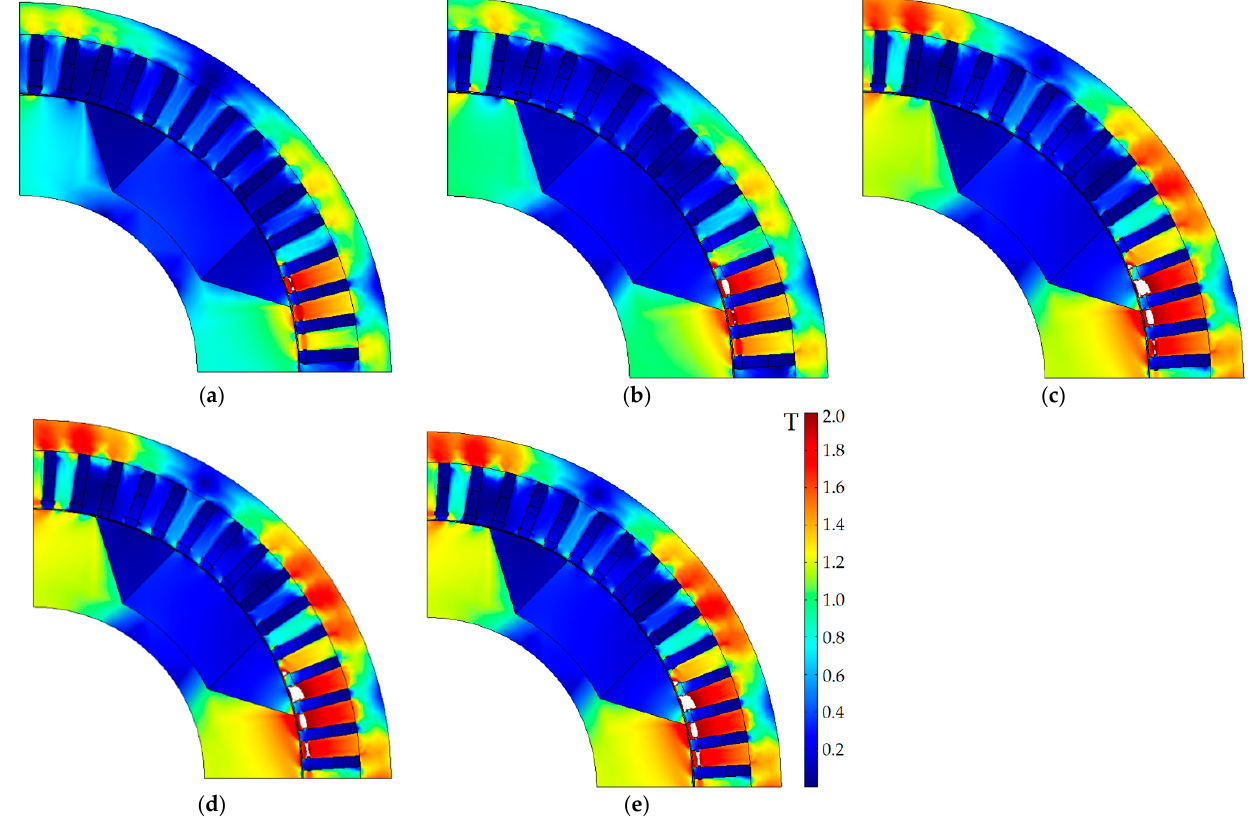
Figure 9. The cross-section of the initial design of the motor and the plot of flux density magnitude; white areas are the extreme saturation areas (>2 T). ( a ) Operating point 1; ( b ) Operating point 2; ( c ) Operating point 3; ( d ) Operating point 4; ( e ) Operating point 5.